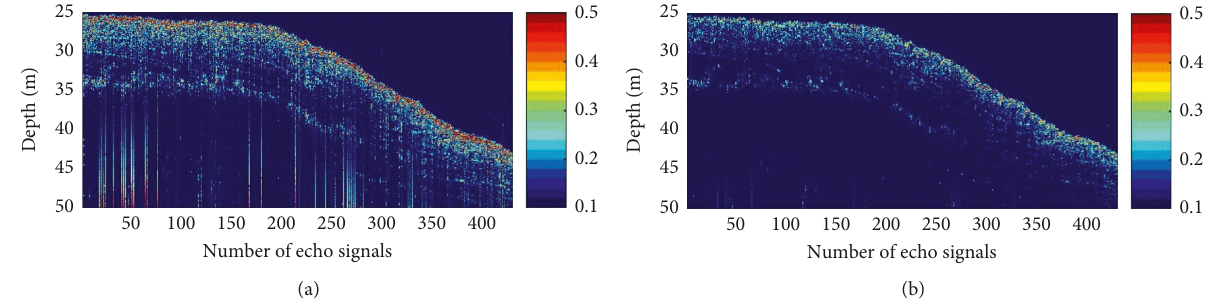
Figure 8: Seabed profile. (a) The original signal. (b) The result of single-channel blind signal separation